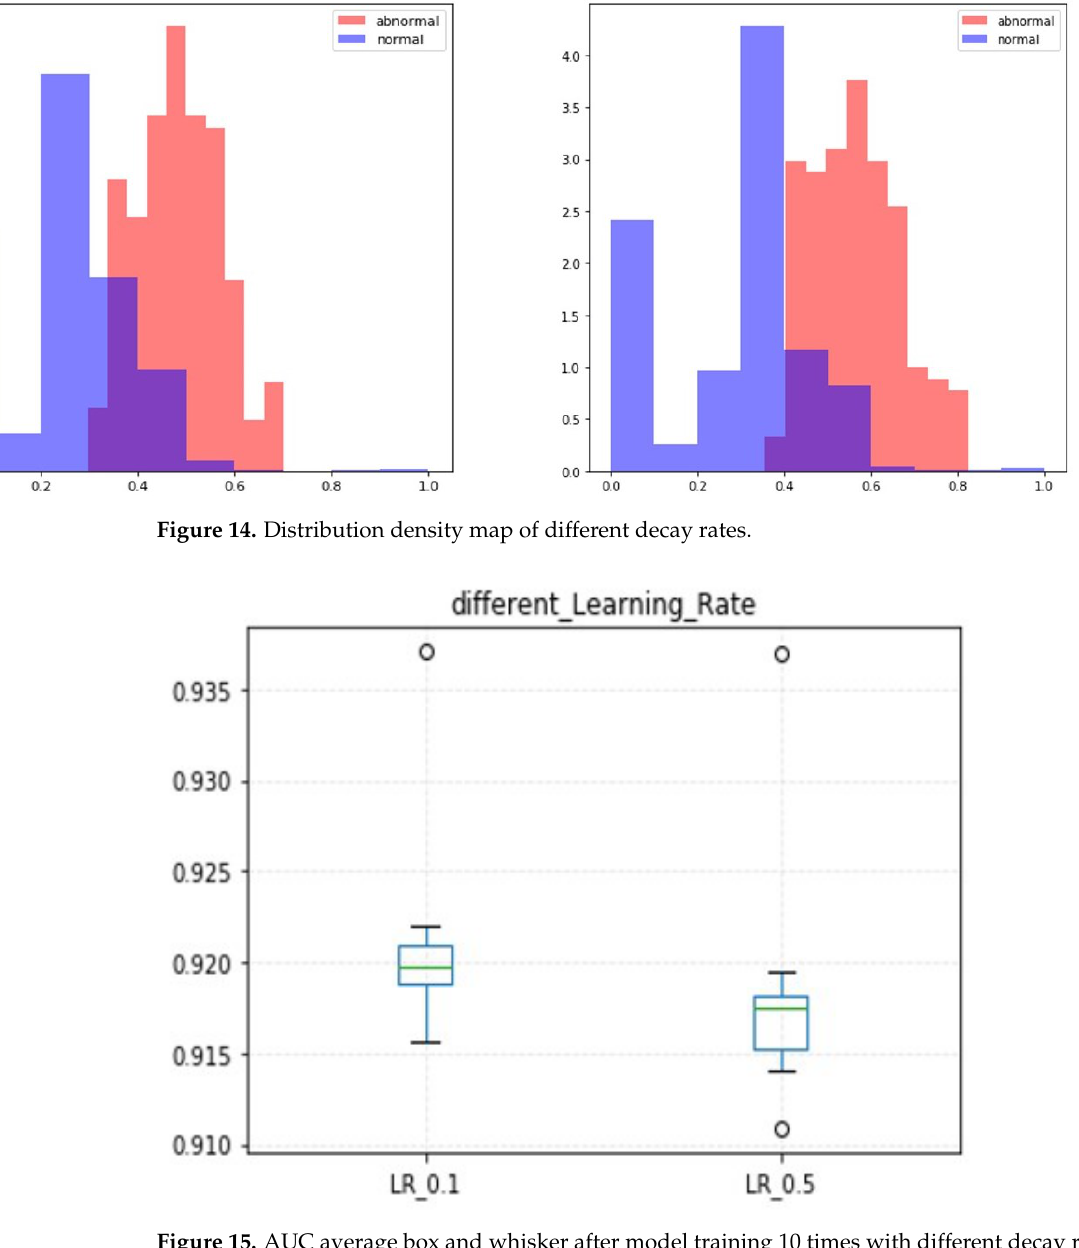
Figure 15. AUC average box and whisker after model training 10 times with different decay